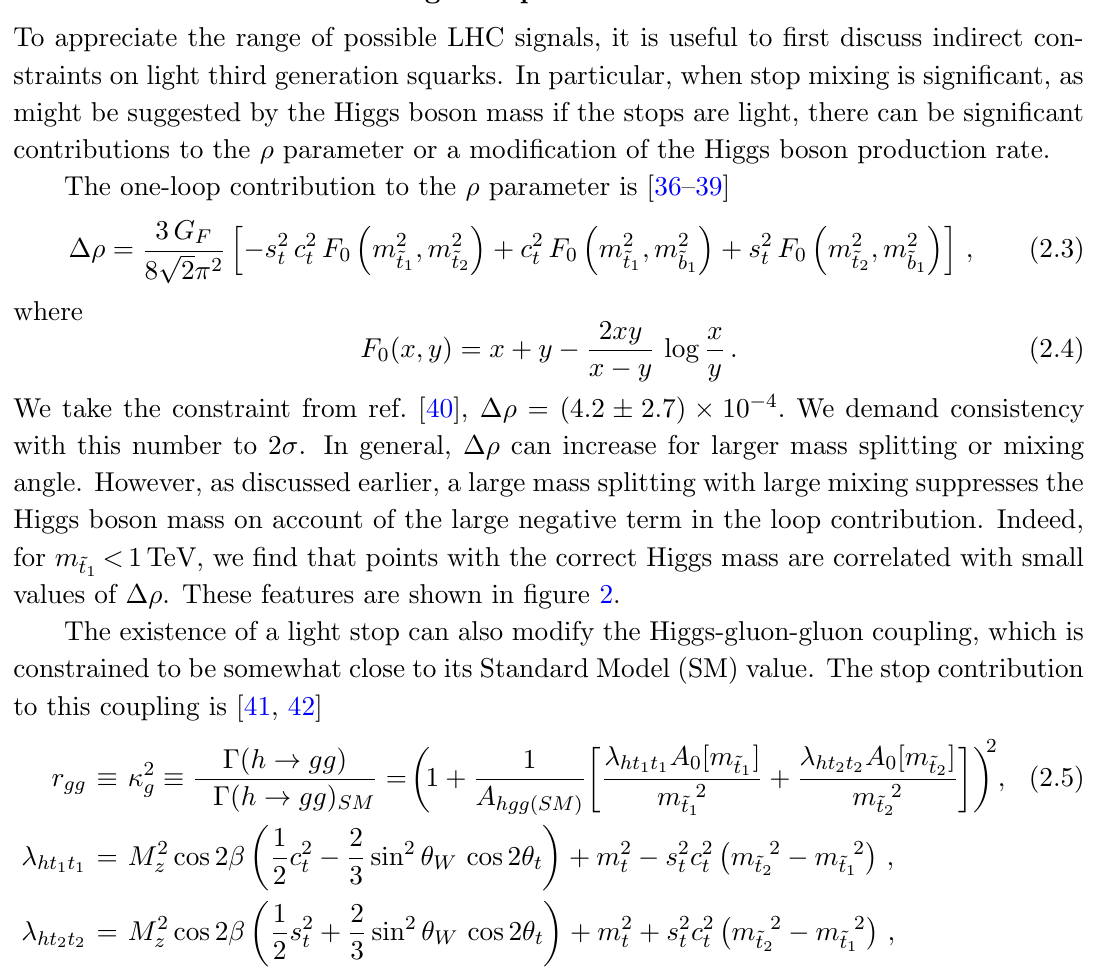
< 1 TeV, t 1 (cid:20) 1. The horizontal blue t